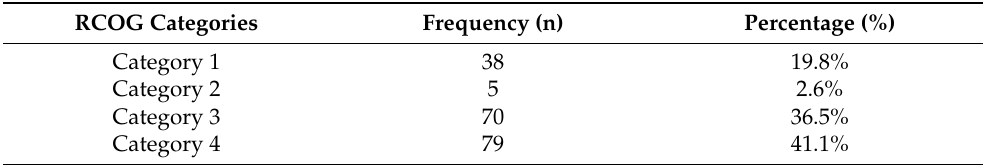
Table 3. Classification of CS based on Royal College of Obstetricians and Gynecologists (RCOG) categorization.